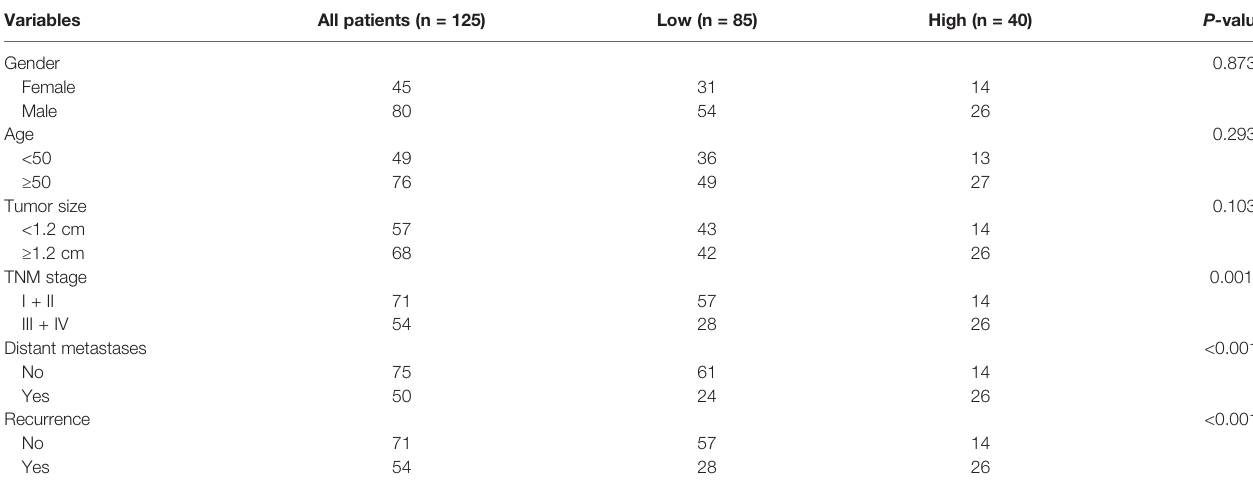
TABLE 1 | Clinicopathological features and NSUN2 in NPC.